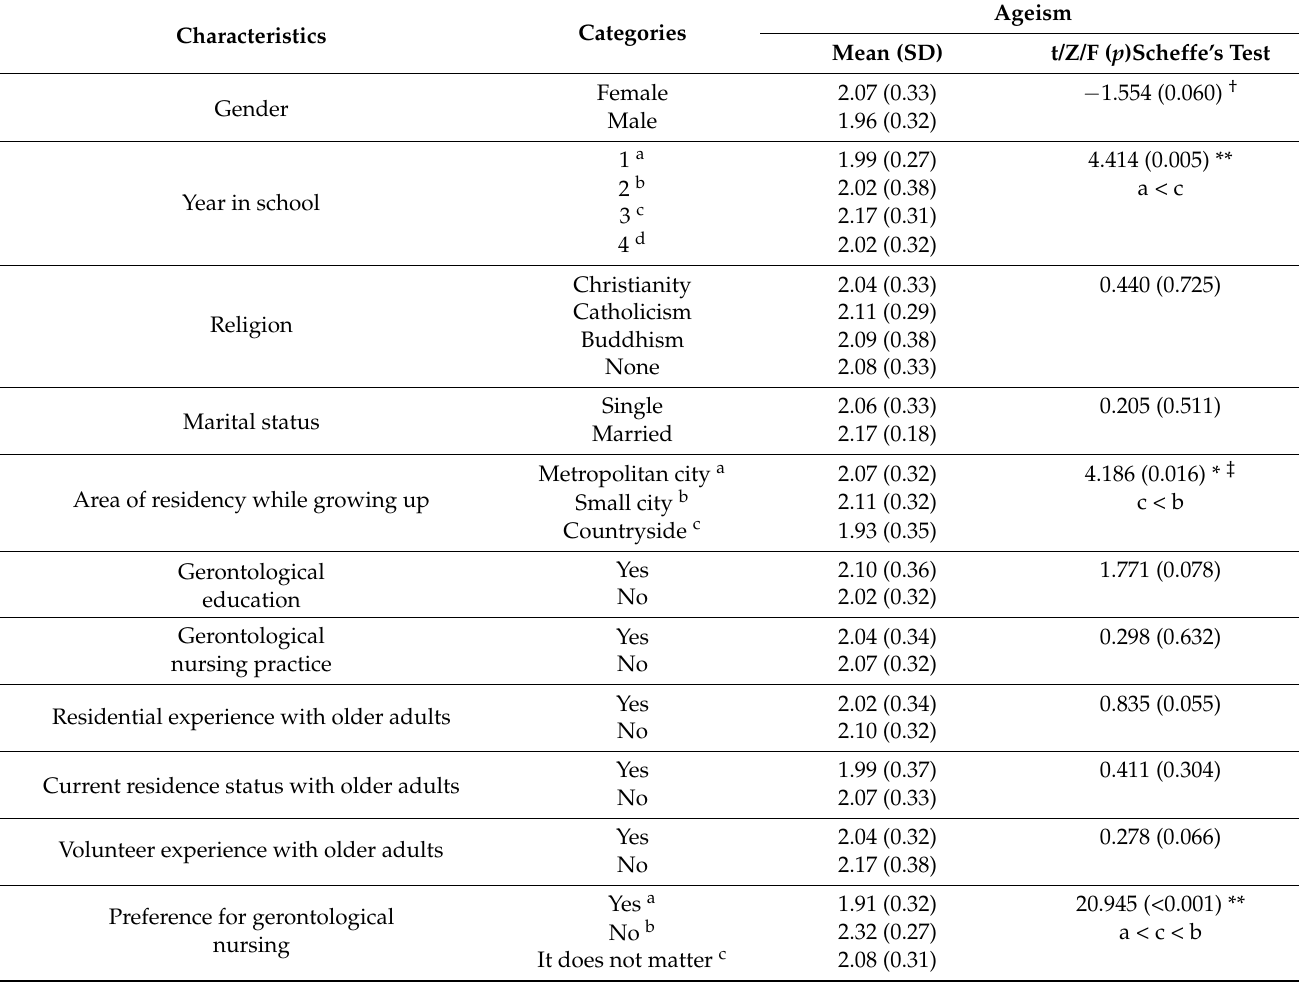
Table 3. Differences in ageism according to participant characteristics ( N = 238).